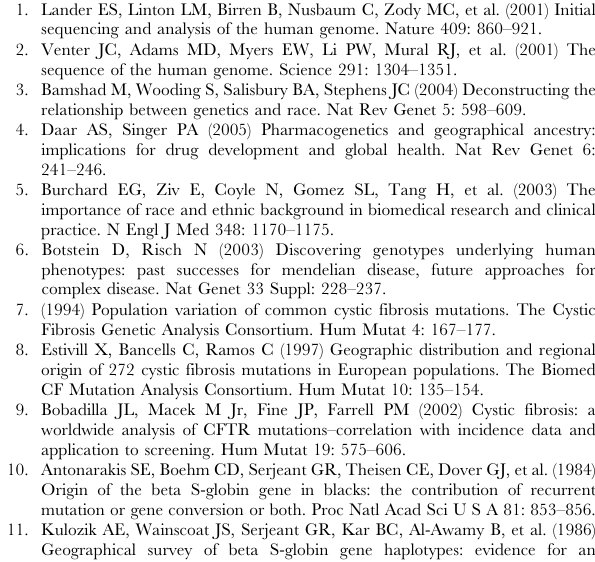
Table S10 Evaluation of selective pressures on SNPs tagging CNVs. SNPs having the highest LD in the population in which the CNV variant was identified are shown in the table. We have recovered FST values calculated after pairwise population comparisons from Barreiro et al, (2008). The Inferred Pop column indicates to which population is attributable the differentiation, according to pairwise comparisons of the SNP FST. We used a strict criterion and assumed values above 0.20 to be indicative of population differentiation. iHS stands for integrated Haplotype Score (Voight et al, 2006) and absolute values higher than 2